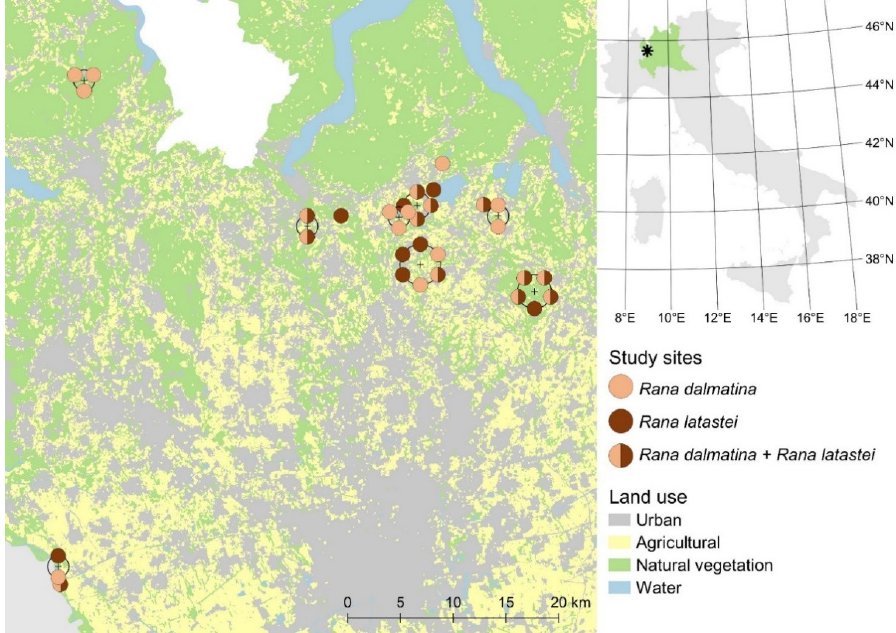
Figure 1. Location of the 32 studied wetlands in northern Italy, with indication of the sites where egg clutches of Rana dalmatina (light brown) and Rana latastei (dark brown) were detected. The position of areas with multiple overlapping wetlands at this scale is indicated by crosses, and the dots indicating species presence are placed on circles surrounding these crosses. The position of the Lombardy region in Italy is highlighted in green in the top-right inset and the location of the study area is indicated by a black asterisk.